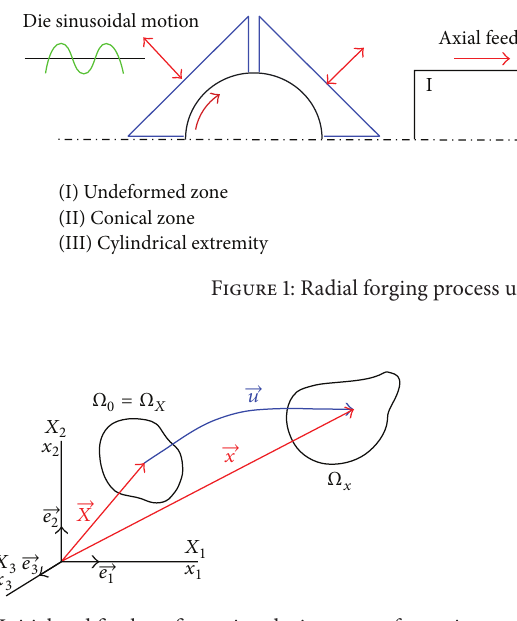
those reasons the finite element method (FEM) is now widely used to simulate and analyze the forming